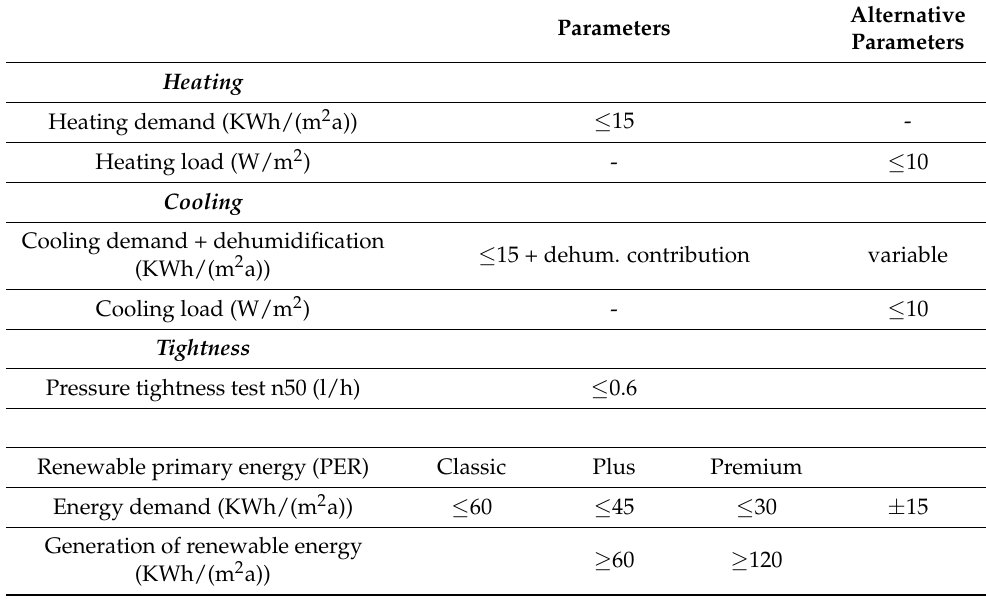
Table 2. Thermal transmittance in Spain´s C2 zone [17].